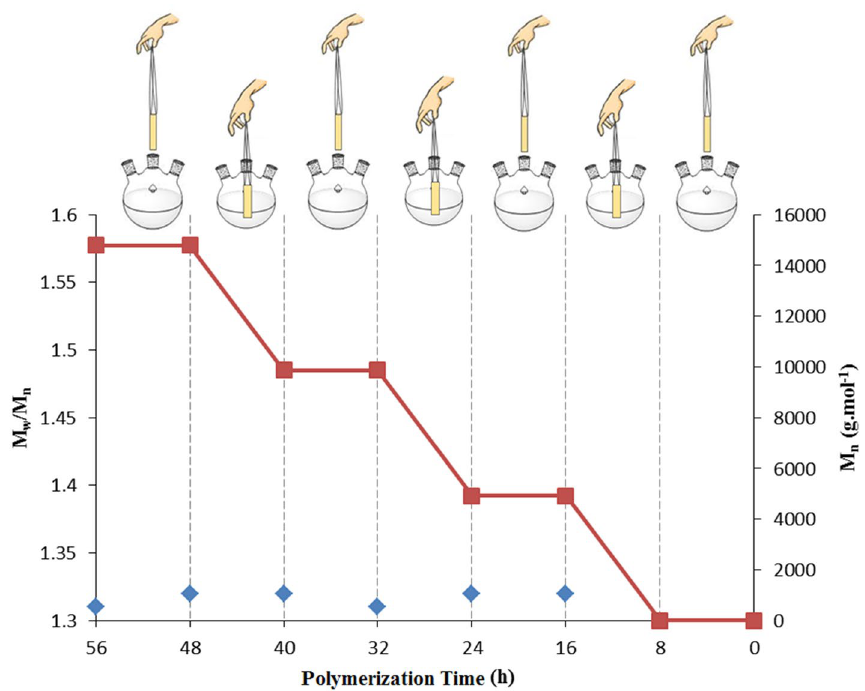
Figure 8. The role of catalyst in polymerization using the Cu@CS-FP catalyst.